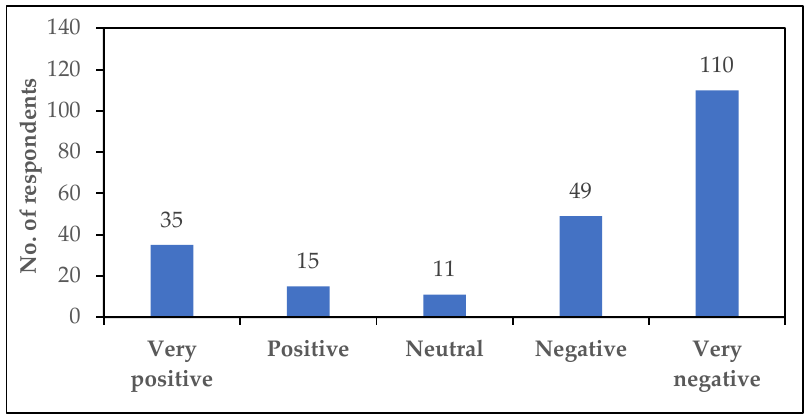
Figure 12. Survey responses against the question, “How would you characterize peri-urbanization in your area?”.